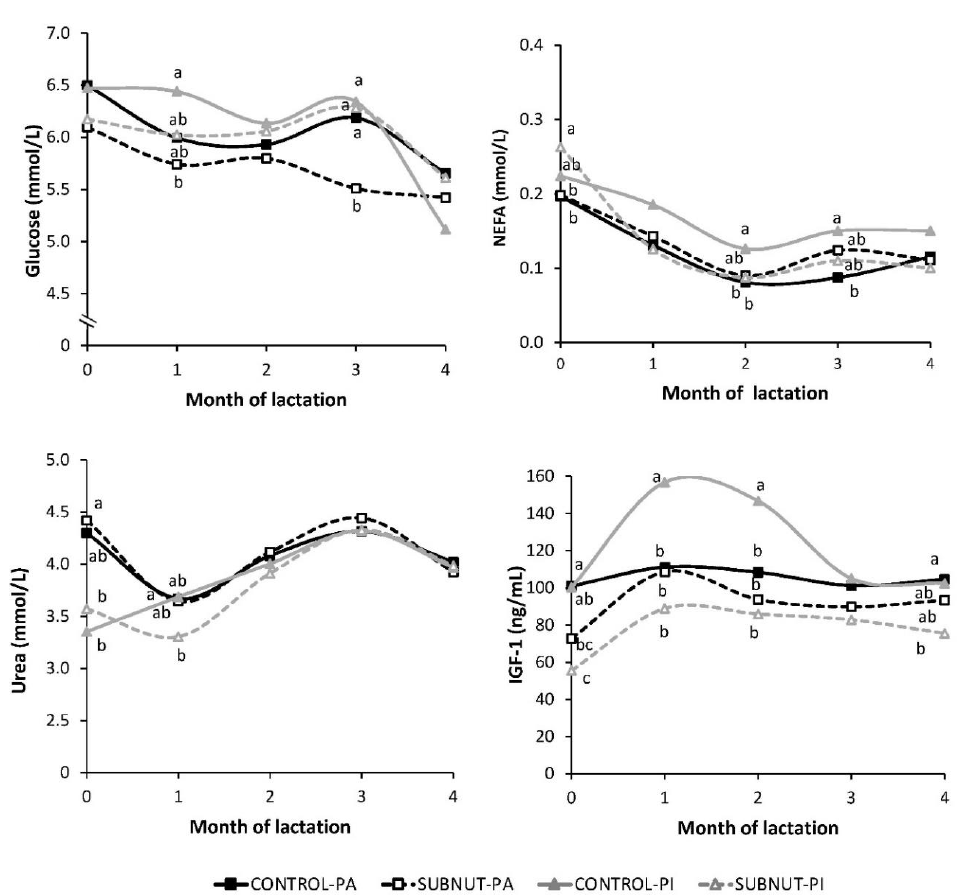
Figure 3. Calf metabolic and endocrine profiles throughout lactation, according to the nutritional treatment and the breed. a,b,c Means within a month with di ff erent superscripts di ff er significantly ( p < 0.05); CONTROL, 100% fed group; SUBNUT, 65% fed group; PA, Parda de Montaña; PI,